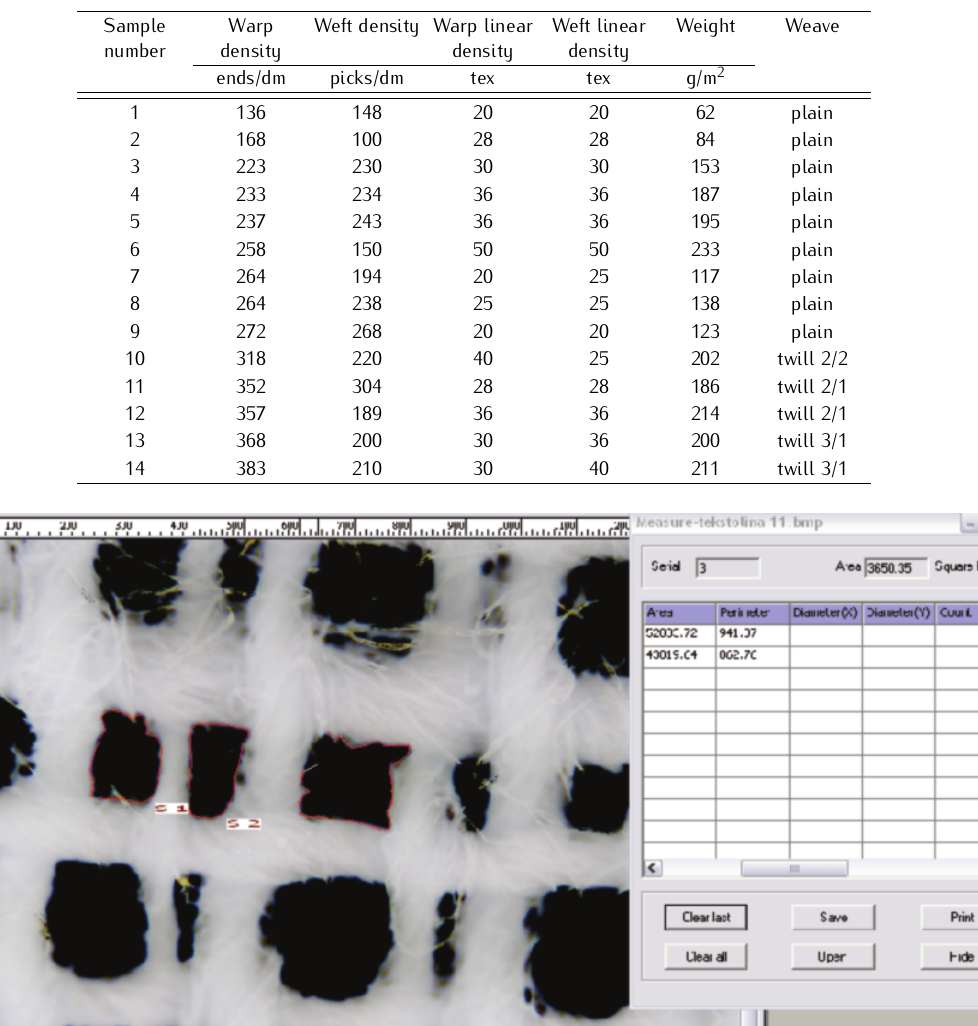
increases, the error will decrease; the tradeoff is an in- crease in measurement effort and thus an increase in over- all analysis time. On the best of the present author’s ex- perience, the additional costs of such measurement would not be compensated by the accuracy of the obtained mean value of the pore area, due to the great dispersion of the single results. Fig. 5 shows results for the single measurements, together with the mean value and stan- dard deviation of the pore area for two of the samples – 4 (Fig. 5(a)) and 11 (Fig. 5(b)).